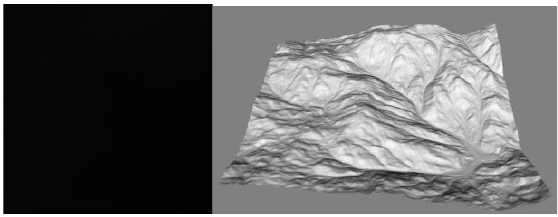
Figure 1. Heightmap (left) and corresponding 3D landscape